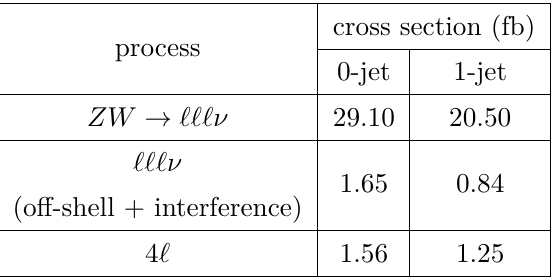
Table 3 . Cross sections of the on-shell ZW , off-shell plus interference and four-lepton 4 ‘ background processes after geometrical acceptance cuts presented in table 1 and the pre-selections cuts, with ‘ = µ .